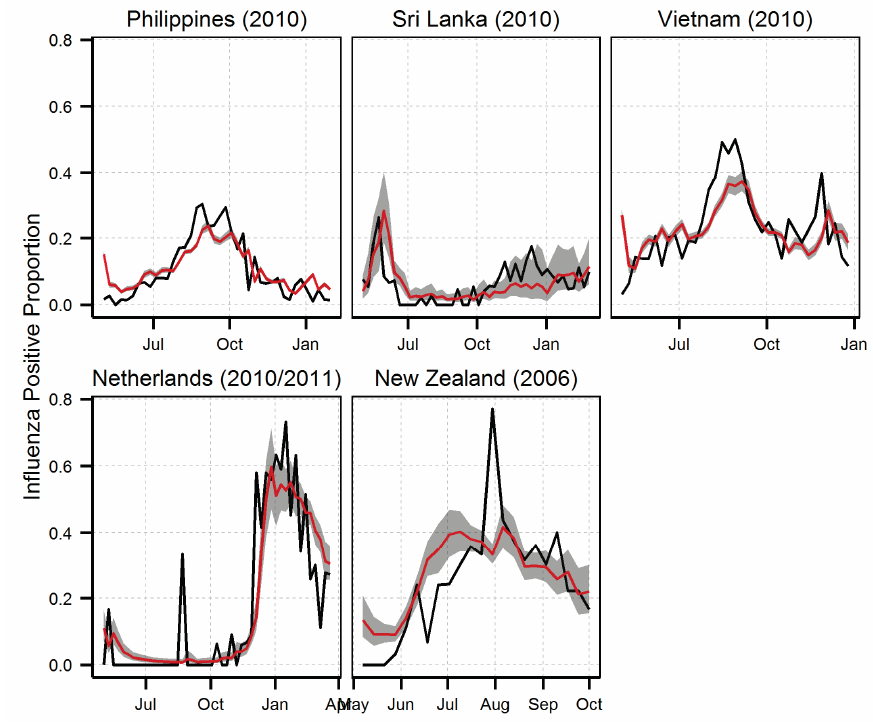
Figure 4. Regression models prediction of influenza positive proportion during the indicated period. The black line is the observed data (validation dataset, not used in training the models), and the red line is the model prediction with grey shades indicating the 95% Confidence Interval